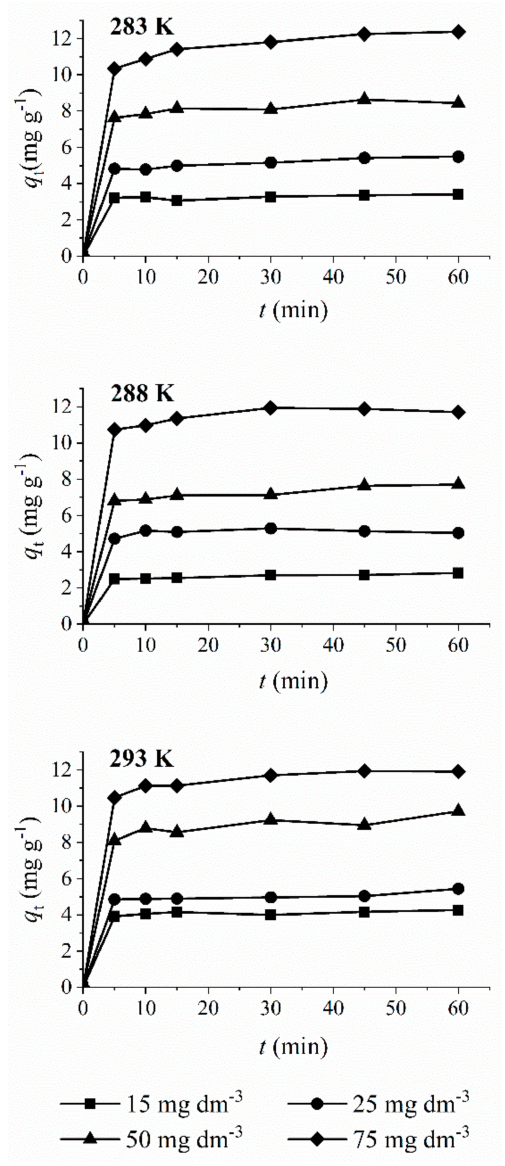
Figure 12. Adsorption kinetics for CIP on MAG-CLI for different temperatures; q t is the amount of the adsorbed antibiotic (mg per 1 g of MAG-CLI) after time t